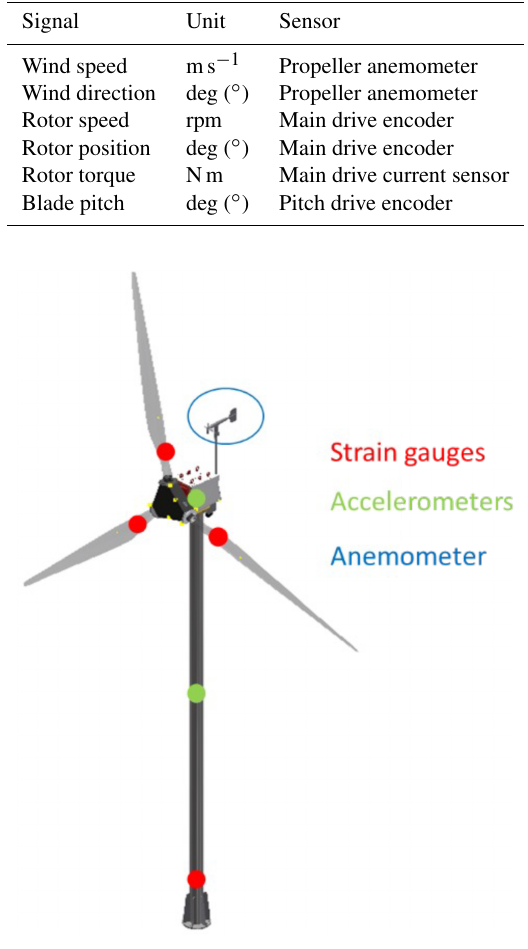
Figure 4. Anemometer, accelerometer and strain gauge locations.